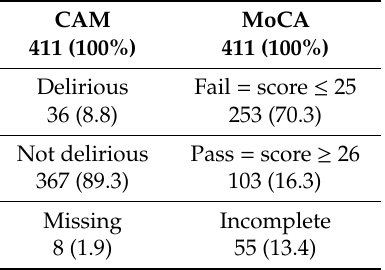
Table 1. The prevalence of delirium and cognitive impairment.